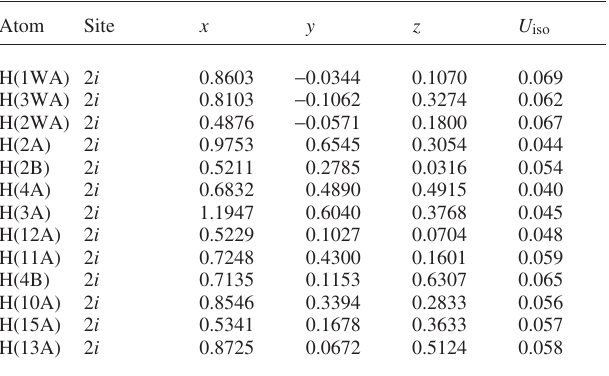
Table 2. Atomic coordinates and displacement parameters (in Å 2 )